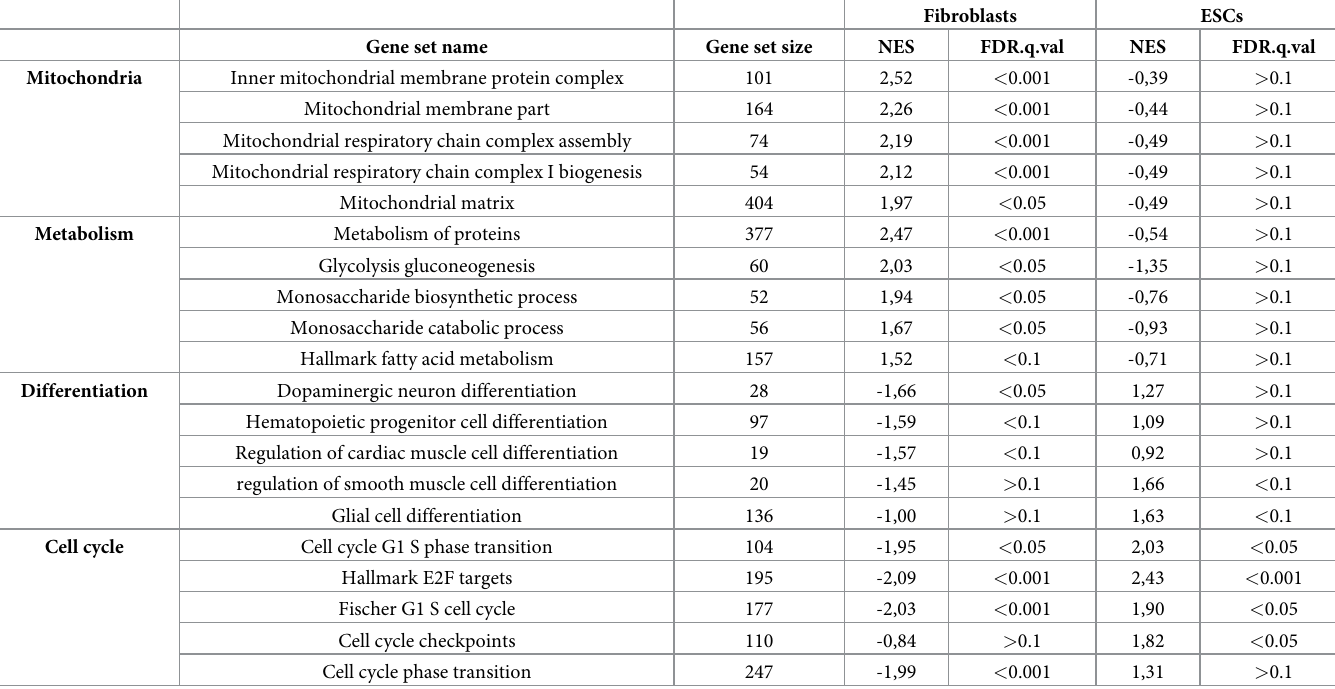
Table 1. Gene sets whose expression exhibits opposite correlations with growth between fibroblasts and